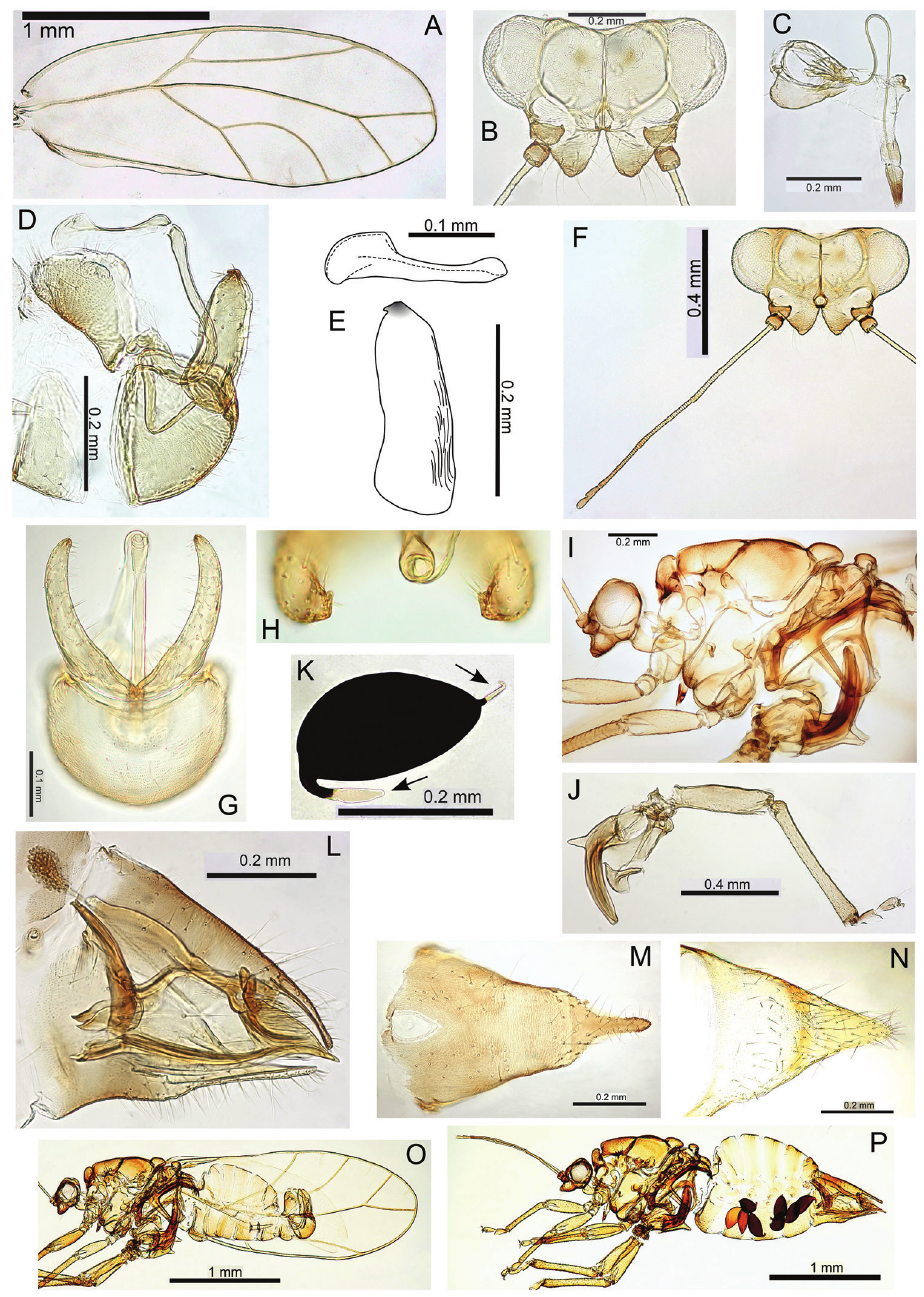
Figure 44. Pariaconus pyramidalis sp. n. A fore wing B head C proboscis D male terminalia E aedeagus and paramere F head and antenna G male terminalia (posterior view) H paramere apices (dorsal view) I head and thorax J hind leg K egg (pedicel and tail indicated) L female terminalia M female proctiger (dorsal view) N female subgenital plate (ventral view) O male P